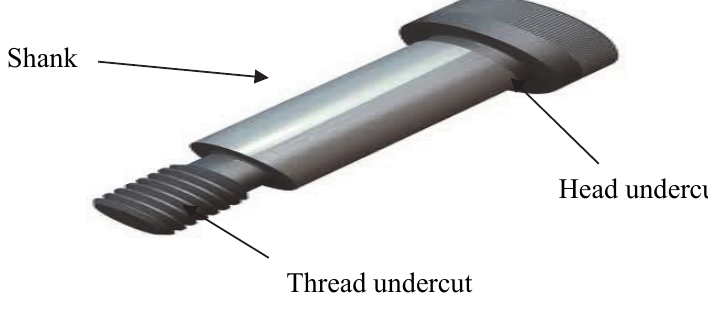
Fig. 1. Pictorial View of Shoulder